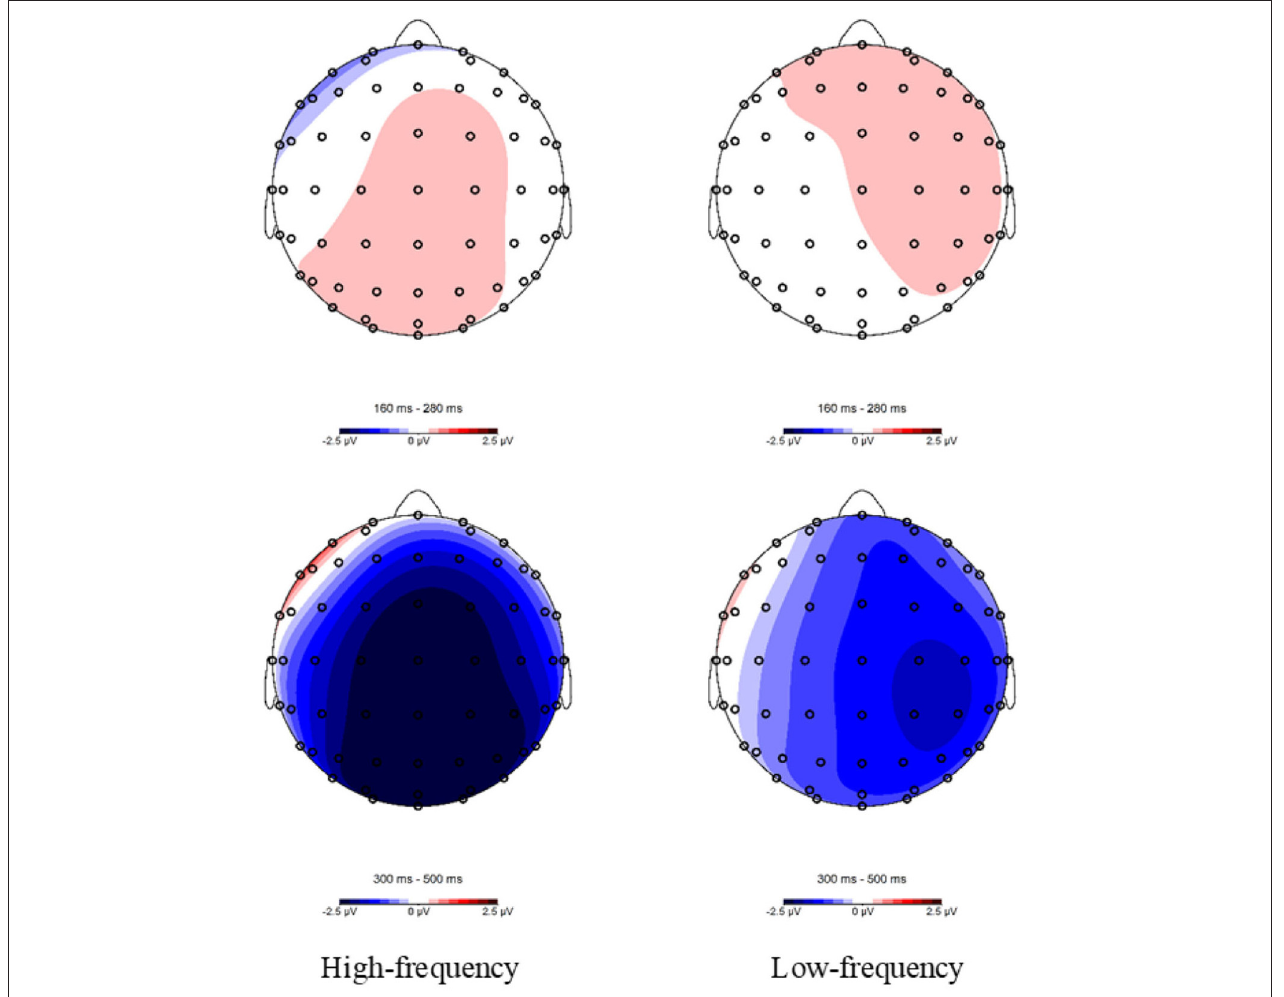
FIGURE 5 | Topographic maps of the different waves in the semantic task for the 160–280 (homophonic minus control) and 300–500-ms (control minus homophonic) epochs following target onset.